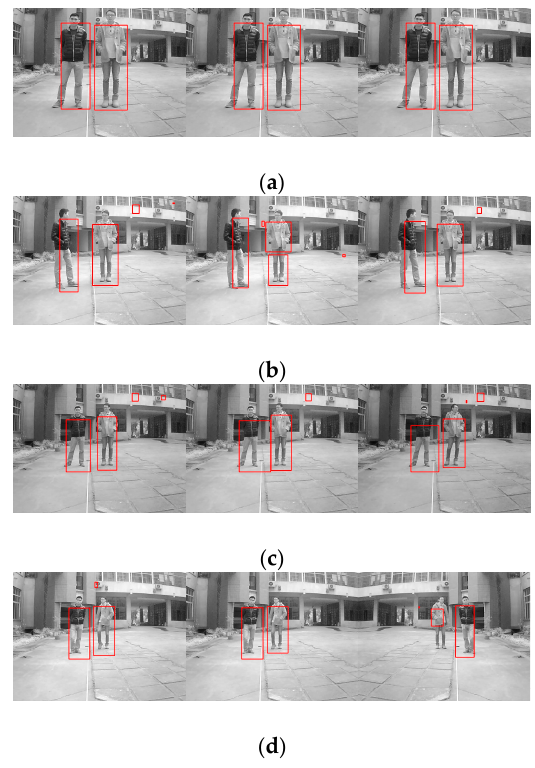
Figure 16. Obstacle detection results: ( a ) Obstacle detection results at 1.0 m; ( b ) Obstacle detection results at 1.0 m; ( c ) Obstacle detection results at 1.0 m; ( d ) Obstacle detection results at 1.0 m.